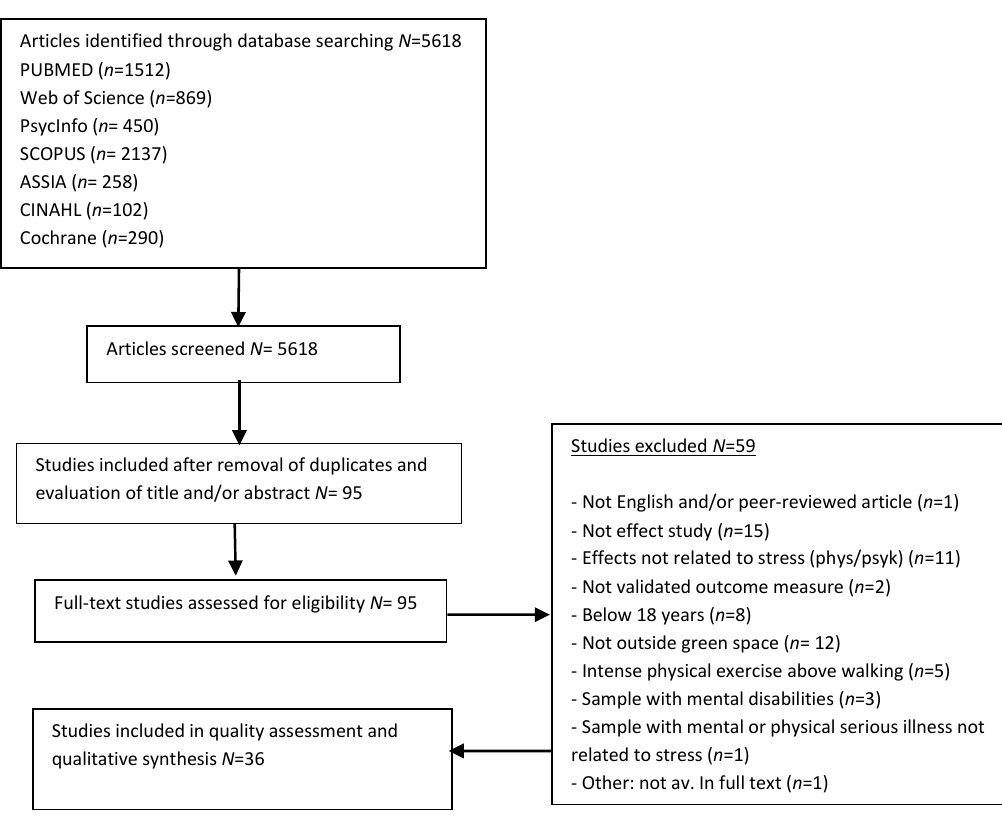
Figure 1. Flow diagram of article-selection process.